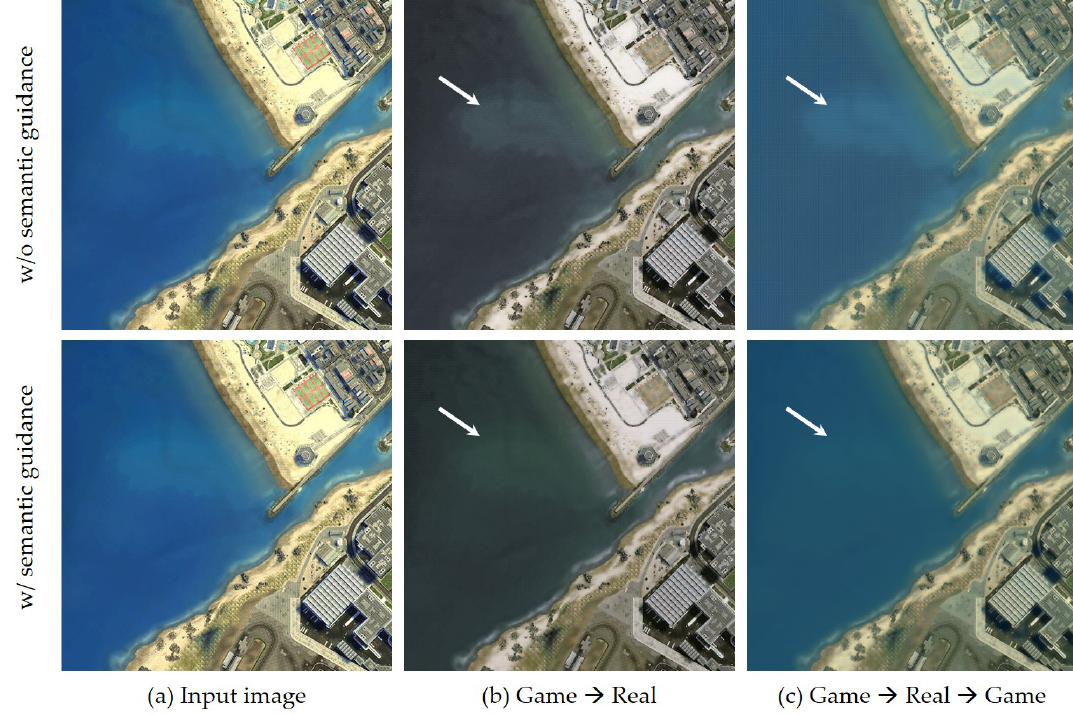
Figure 6. (Better viewed in color) A visual comparison of style transfer results with different configurations. The first row corresponds to the results of the original CycleGAN [26] and the second row corresponds to the results of our method. Columns: ( a ) input game data, ( b ) game → real, ( c ) game → real → game. We can see that the images generated by our method are closer to the target domain and thus helps cross-domain segmentation. Some unrelated image contents (e.g., the pollution area marked by the arrows) have been successfully removed during the